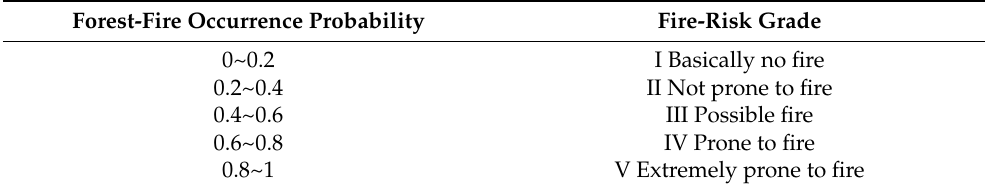
Table 4. The standard of forest-fire-risk grade division. Forest-Fire Occurrence Probability